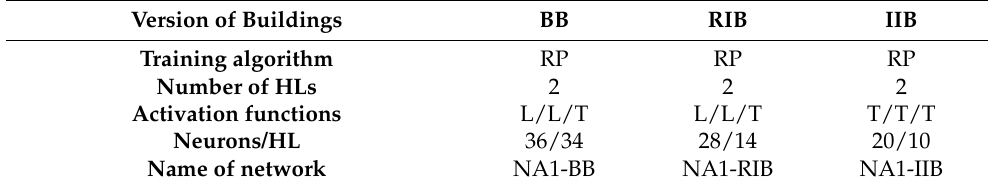
Table 7. Configuration parameters and names of the optimal networks used for A1.